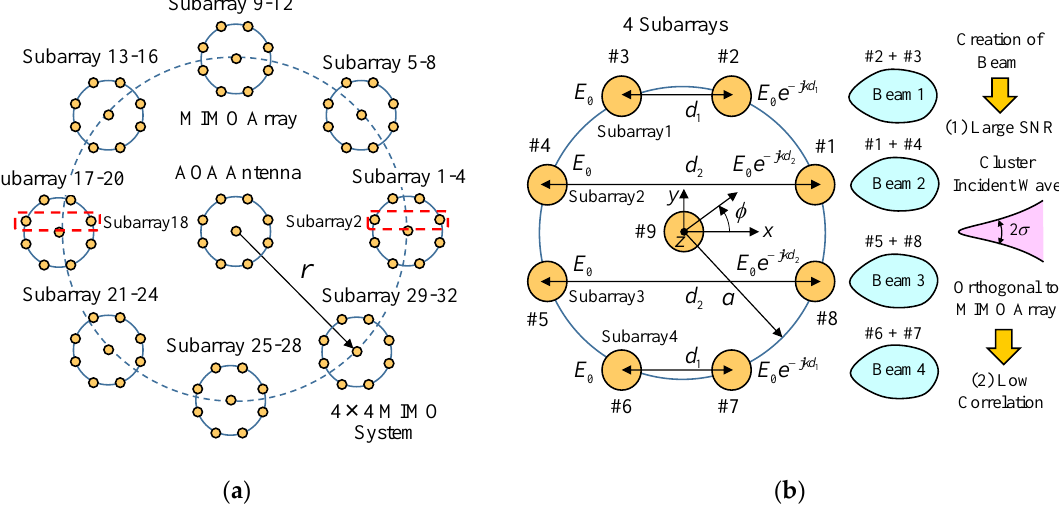
Figure 3. Beam steering MIMO antenna arranged in a daisy chain array structure. ( a ) The whole structure of a 32 × 32 MIMO system. ( b ) 4 × 4 MIMO system.